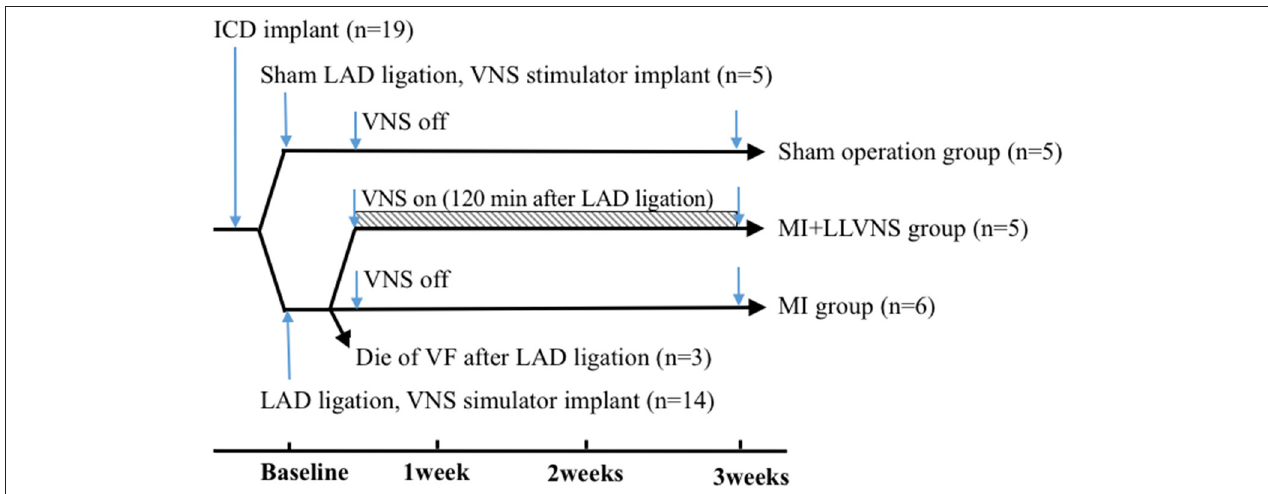
FIGURE 1 | Timeline of the experimental protocol. ICD, implantable cardioverter defibrillators; LAD, left anterior descending coronary artery; VNS, vagus nerve stimulation; VF, ventricular fibrillation; LLVNS, low level left vagus nerve stimulation; MI, myocardial